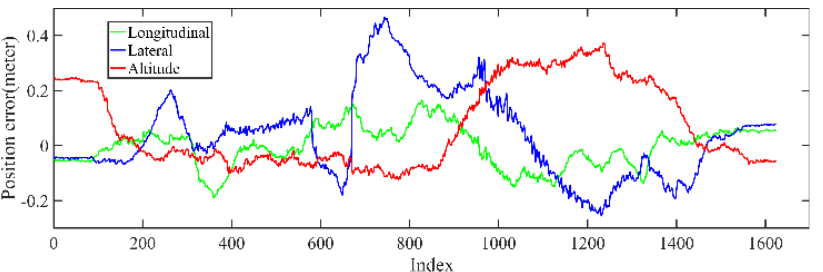
Figure 25. Field test NO.2. One lap under curve driving scenario localization error in longitudinal, lateral, and altitude directions, respectively; the localization error is at the centimeter level.